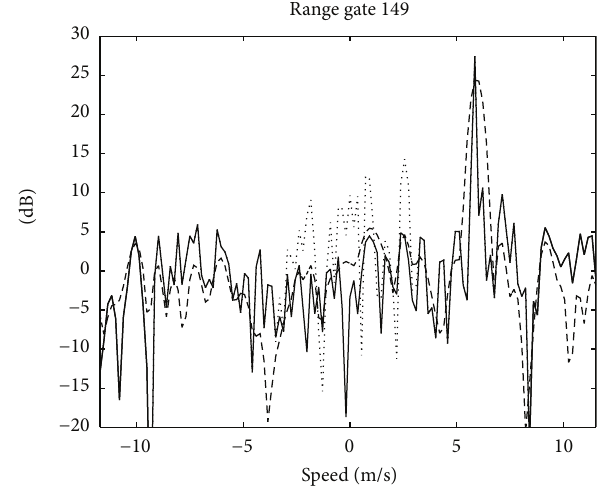
Figure 14: Comparison of classical STAP (dash curve) Stop-Band STAP (dot curve) and deterministic aided Stop-Band (solid curve) on RAMSES data for range gate number 149.